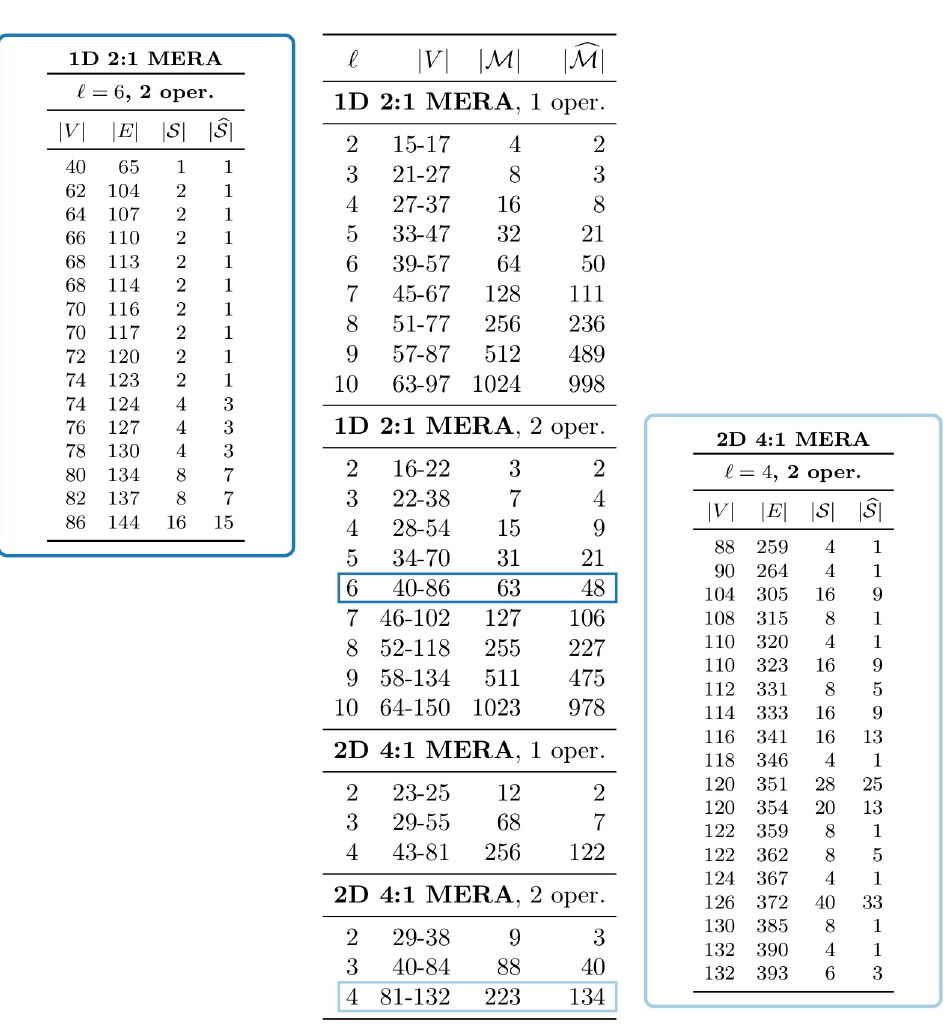
Fig 3. Summary of extended MERA benchmark data. (Center) For each lattice type (1D binary or 2D 4-ary) and number of operators, as the number of levels ℓ varies, we report the number of vertices | V | in the resulting networks, the total number of networks j M j , and the number of unique networks up to isomorphism j ^ M j . (Left, Right) These detailed tables each expand a row from the summary table, specifying the number of networks produced (total j S j and up to isomorphism j ^ S j ), for each pair of values for the number of vertices | V | and number of edges | E |. Note that sum